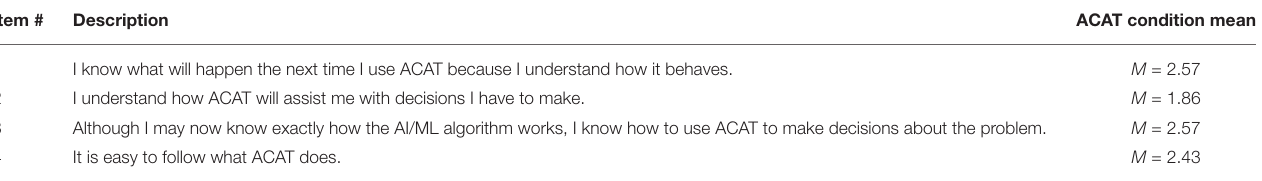
TABLE 8 | Understandability items and their associated rating averaged across all